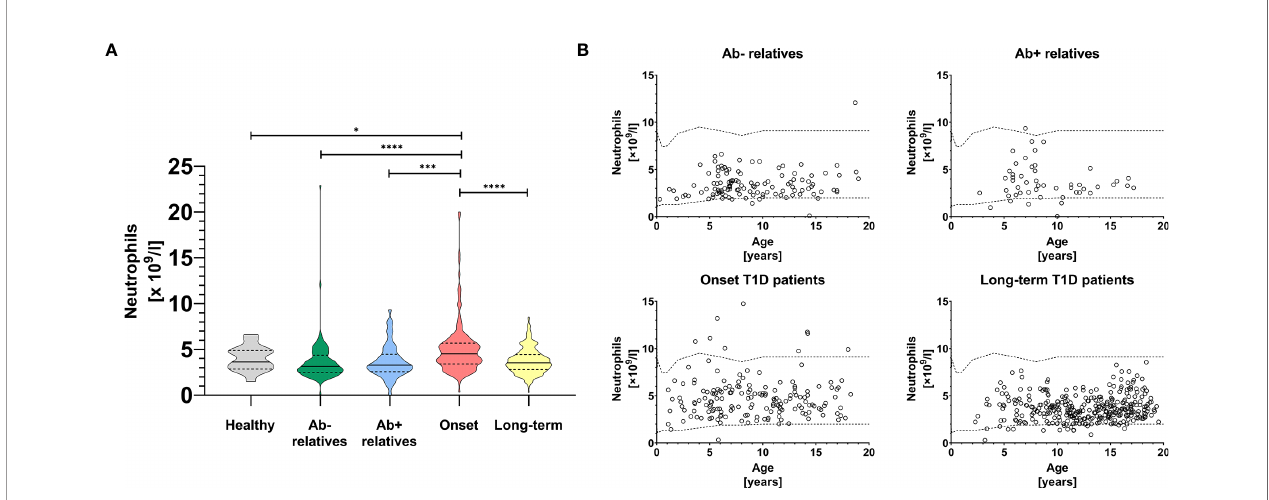
FIGURE 1 | Peripheral blood neutrophils. Absolute neutrophil counts in the peripheral blood of healthy controls, antibody negative and antibody positive fi rst-degree relatives of T1D patients, T1D patients at the clinical onset of the disease and T1D patients with long-term, well-established disease (A) . Temporal development of absolute neutrophil counts in the peripheral blood of healthy controls, antibody negative and antibody positive fi rst-degree relatives of T1D patients, T1D patients at the clinical onset of the disease and T1D patients with long-term, well-established disease (B) . Healthy in-house reference range visualized with dashed line. Unpaired t-test with Welch ’ s correction p-values shown, p=0.01-0.05 (*), p=0.001-0.01 (**), p<0.001 (***), p<0.0001 (****).